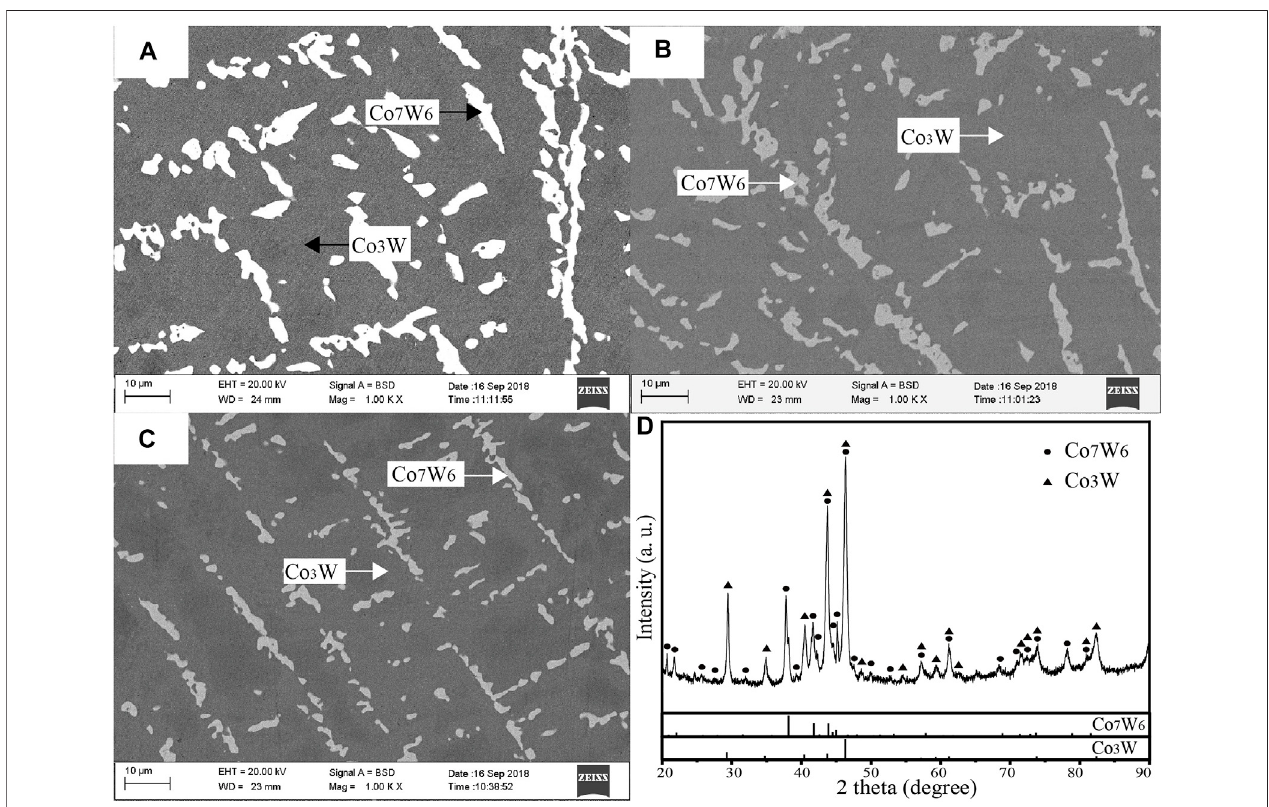
FIGURE 3 | BSE micrographs and XRD patterns of alloys (A) for a4 (B) for a5 (C) and (D) for a6.